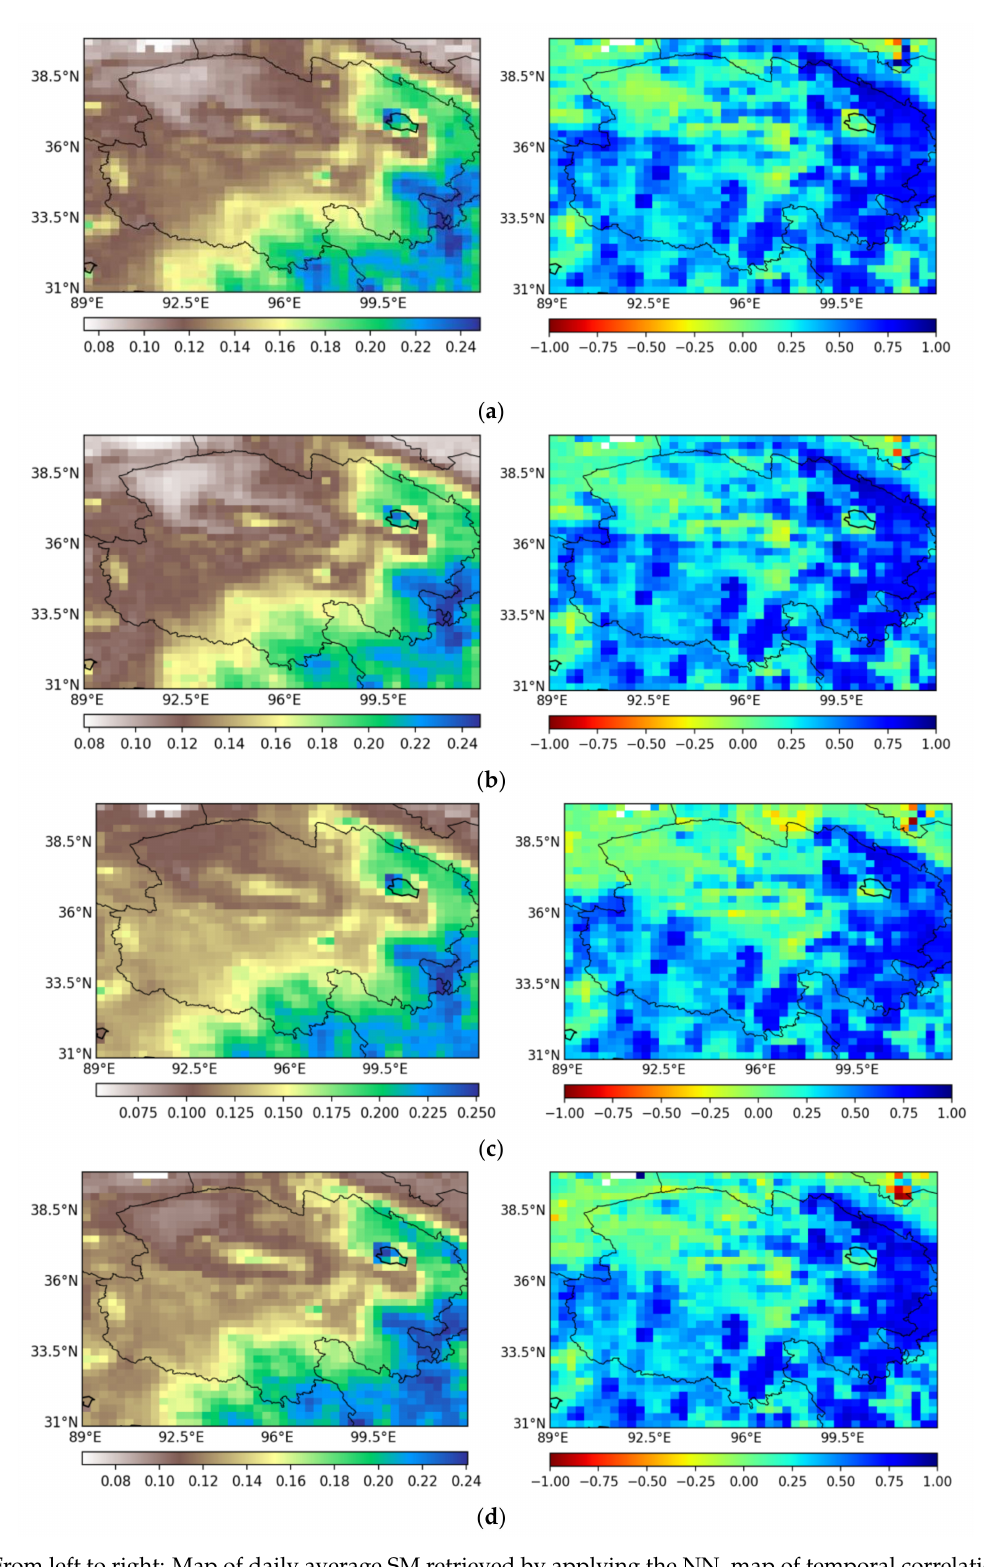
Figure 5. From left to right: Map of daily average SM retrieved by applying the NN, map of temporal correlation between NN soil moisture and CLDAS soil moisture. From top to bottom: ( a ) NN input data: SMAP_TBV_A, AMSR2_TBH_D, and σ 40. ( b ) NN input data: SMAP_TBV_A, AMSR2_TBH_D, and BTI. ( c ) NN input data: SMAP_TBV_A, AMSR2_MPDI_D, and σ 40. ( d ) NN input data: SMAP_TBV_A, AMSR2_MPDI_D, and BTI. SMAP_TBV_A: Ascending Tbv in the 1.41 GHz (SMAP) band; AMSR2_TBH_D: Descending Tbh in the 10.7 GHz (AMSR2) band; AMSR2_MPDI_D: Descending MPDI in the 10.7 GHz (AMSR2) band; σ 40: σ 40 from ASCAT; BTI: BTI from